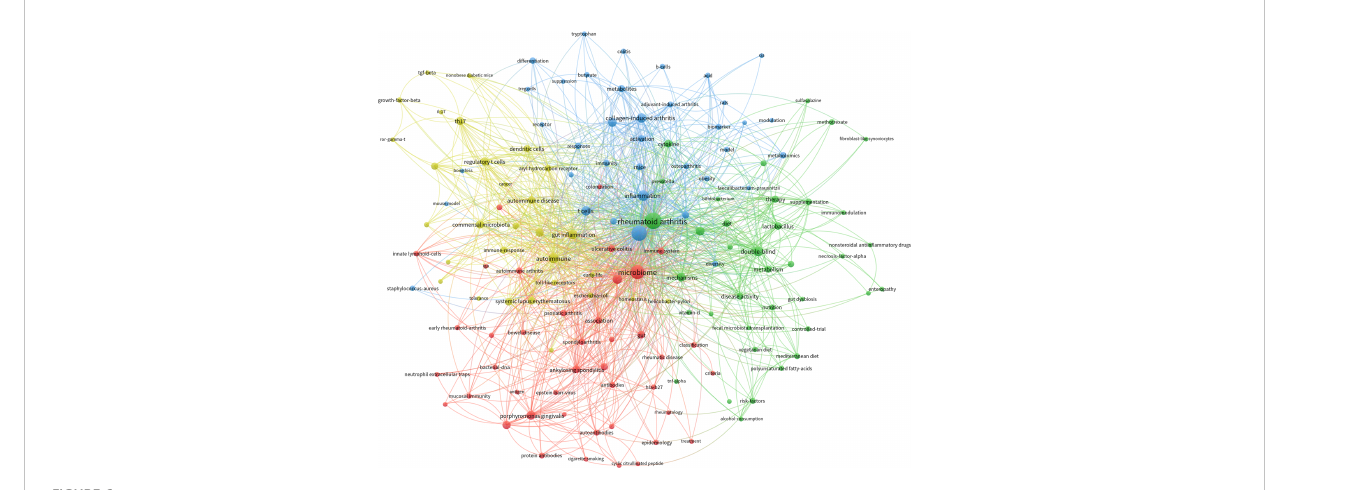
FIGURE 6 Visualization map of keywords co-occurrence network according to